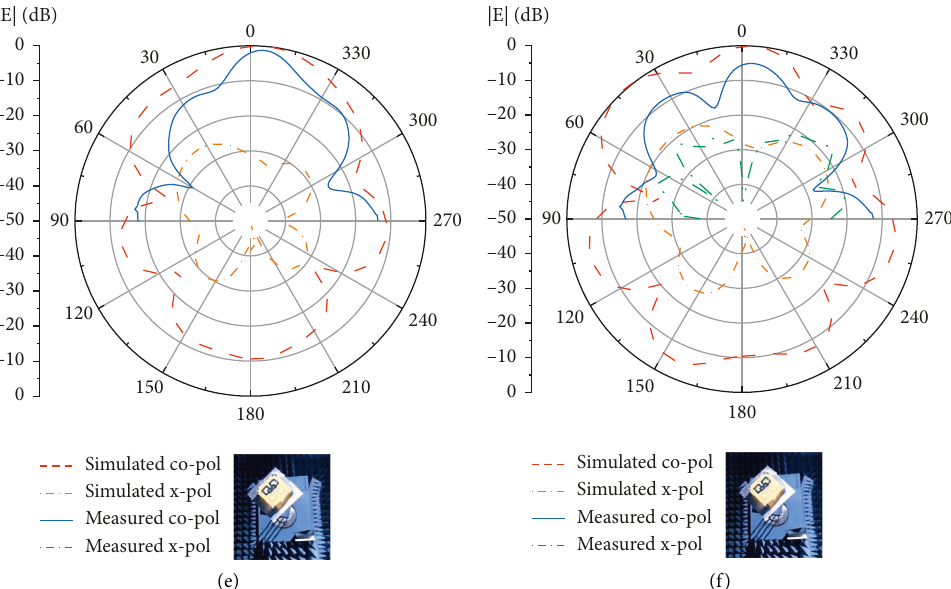
Figure 13: Simulated and measured normalized radiation patterns of the proposed antenna. (a) 0.5GHz. (b) 0.9GHz. (c) 1.3GHz. (d) 1.4GHz. (e) 1.5GHz. (f) 1.6GHz.